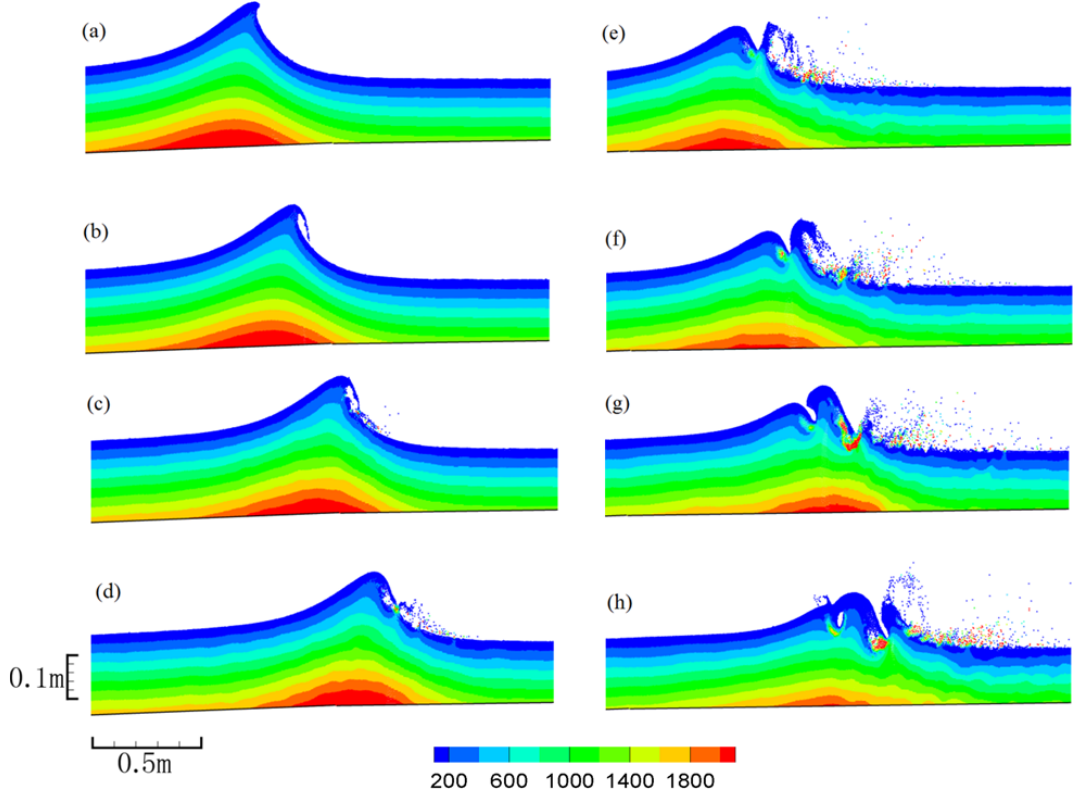
Fig. 8. Snapshots of SPH results (case C) of wave breaking and pressure distribution at time instances (a) 13.1s, (b) 13.2s, (c) 13.3s, (d) 13.4s, (e) 13.6s, (f) 13.7s, (g) 13.8s, (h)